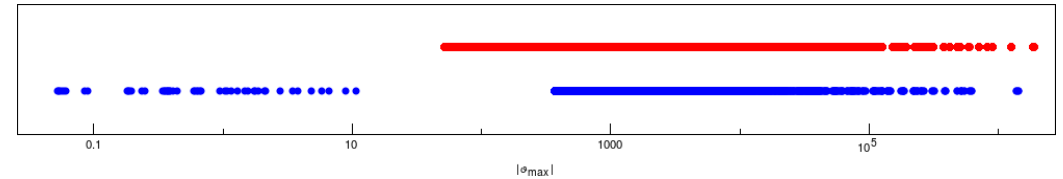
Figure 5 . Distribution of the largest eigenvalues # of the stability matrix of the (cid:12)xed points max of the SU(3) fundamental representation. Blue dots: eigenvalues for the Y -independent solutions: there is a gap between 10.8 and 372. Red dots: eigenvalues for the Y -dependent solutions: there is no gap, the eigenvalues start at